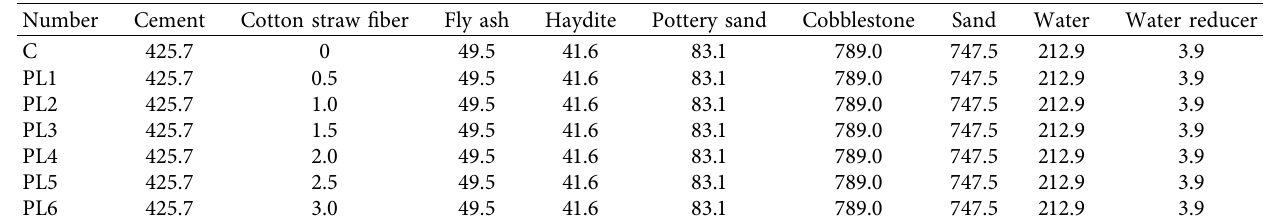
Table 5: Mix proportion design of plant fiber shotcrete (kg/m 3 ).